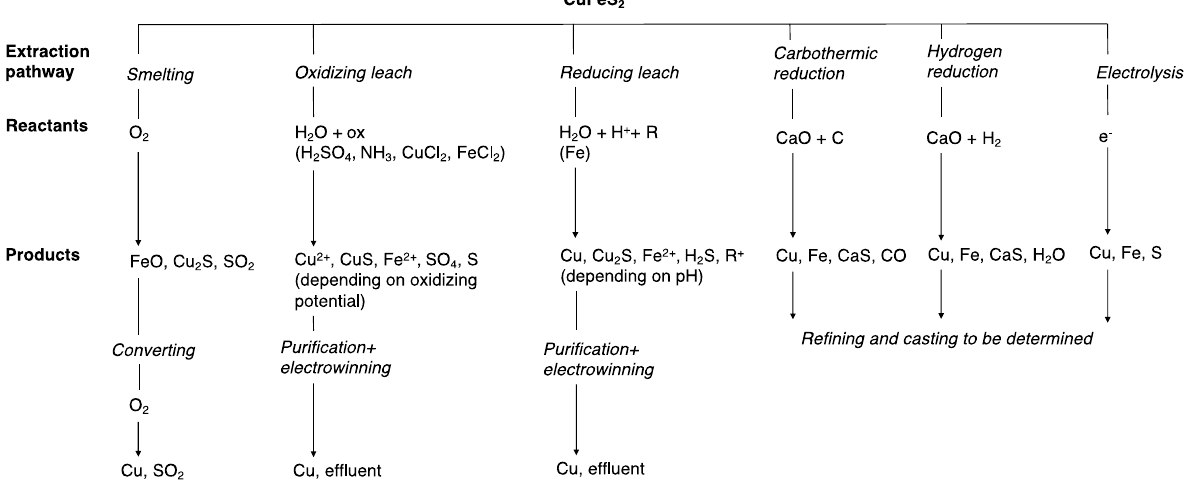
Figure 1. Investigated pathways to extract copper from chalcopyrite. Ox: oxidant, R: reductant.